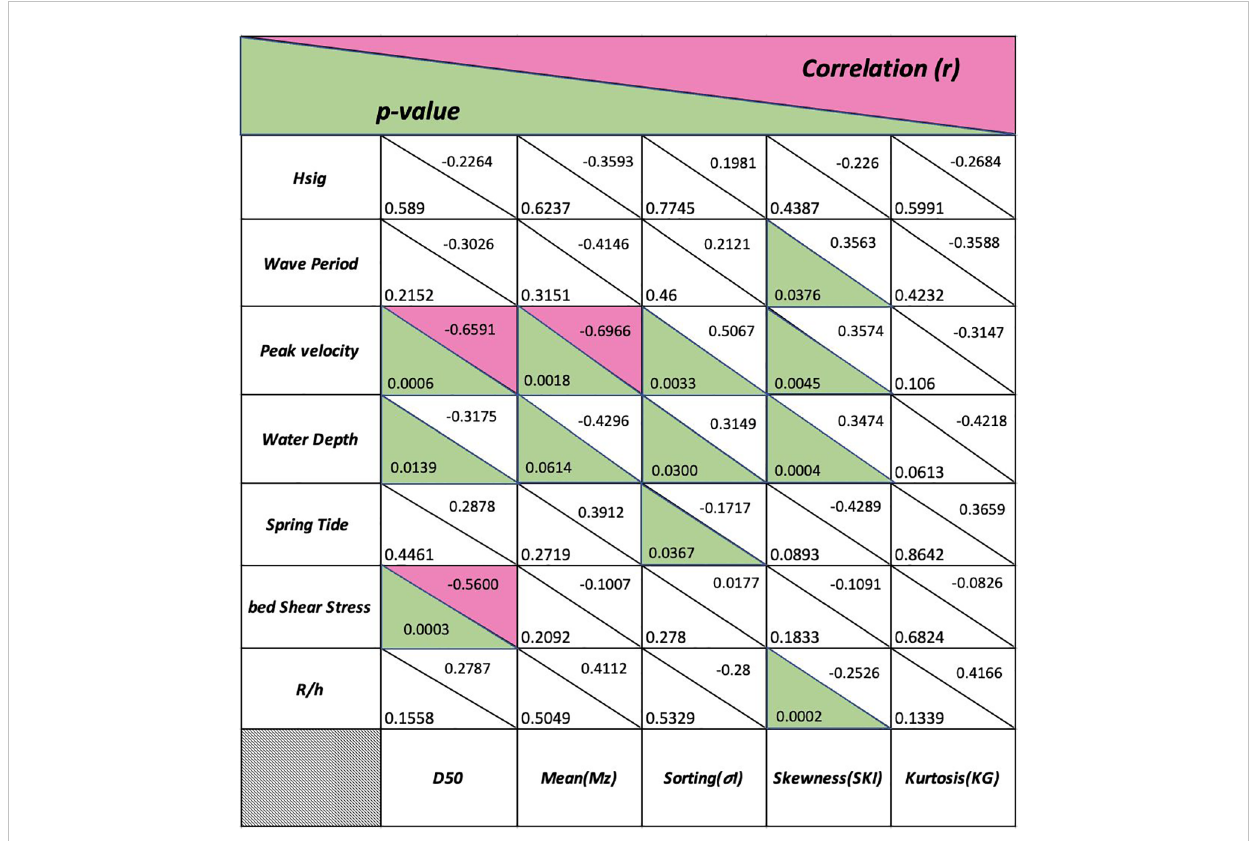
FIGURE 12 The result of Correlation and Regression analysis (green color indicates p-value < 0 : 05, and pink shows moderate or strong correlation ( r )). R = h is the ratio of spring tidal range ( R ) to water depth ( h